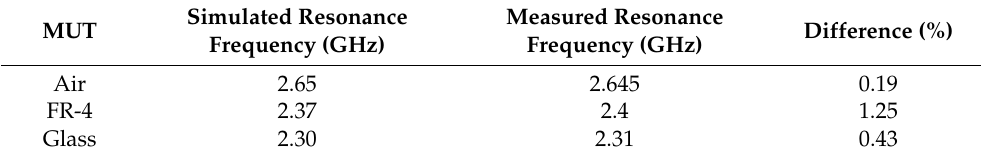
Table 2. Simulated and measured results for MUTs.